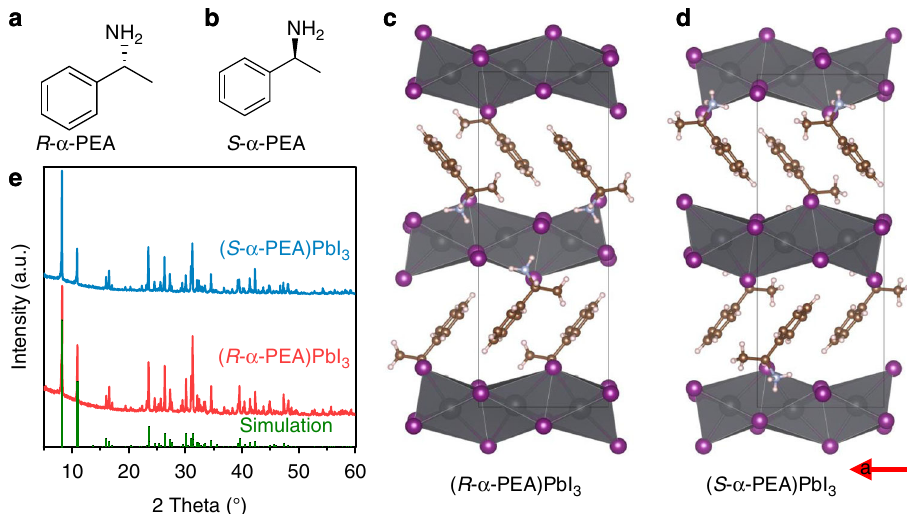
Fig. 1 The crystal structures and properties of our chiral perovskites. a , b Molecular structures of R - and S - α -PEA. c , d The crystal structure of ( R - and S - α - PEA)PbI 3 . The gray, rose red, golden yellow, light blue, and fresh pink dots stand for Pb, I, C, N, and H atoms, respectively. e Powder XRD patterns of ( R - and S - α -PEA)PbI 3 . The simulated XRD peaks are shown as a sensitivity. Δ n / n as a function of ( α -PEA)PbI 3 thickness ( d ) can